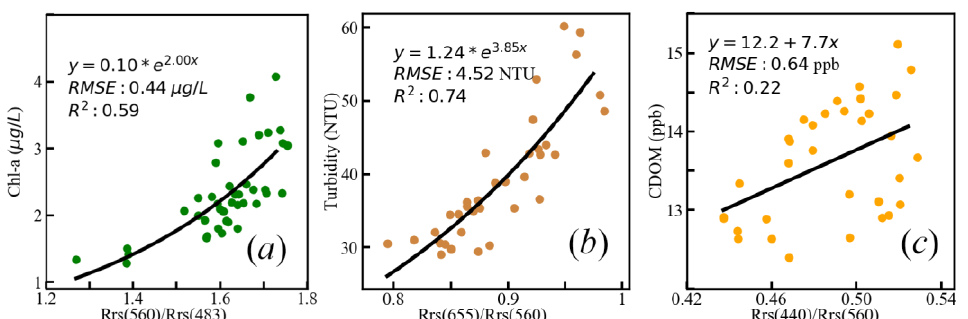
Figure 13. Regression model of water quality parameters with the ratio of simulated Landsat 8 OLI (Operational Land Imager) remote sensing reflectance. ( a ): Chl-a, ( b ) turbidity, ( c ) CDOM. Significant relationships between Chl-a and turbidity and specific band ratios were observed with the determining coefficients of 0.59 and 0.74, and the root mean squared errors of 0.44 μg/L and